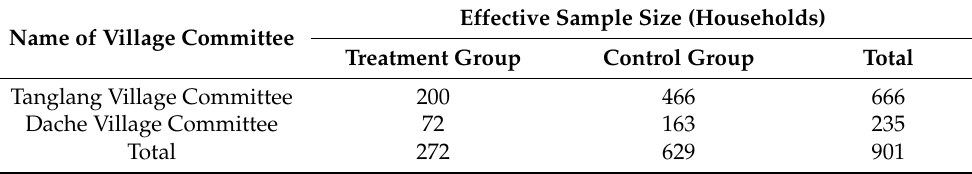
Table 3. Sample Scale of Household Survey on Poverty Alleviation Effect of Sorghum Planting.